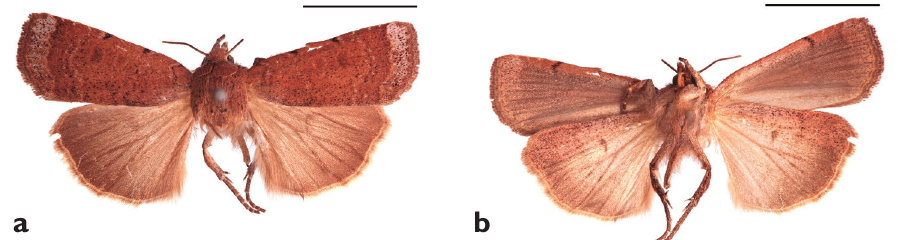
Figure 16. Holotype of Abagrotis crumbi race benjamini Franclemont. a Dorsal b Ventral. Scale bars: 1 cm (Photos B. Proshek).